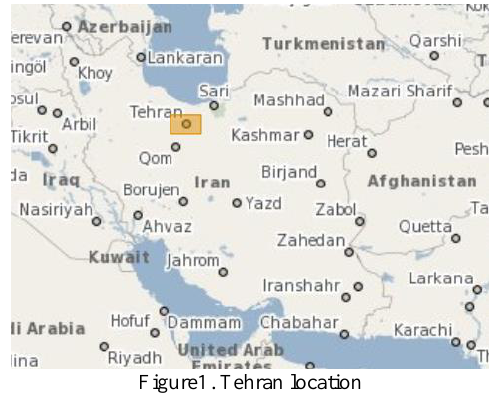
Figure1. Tehran location